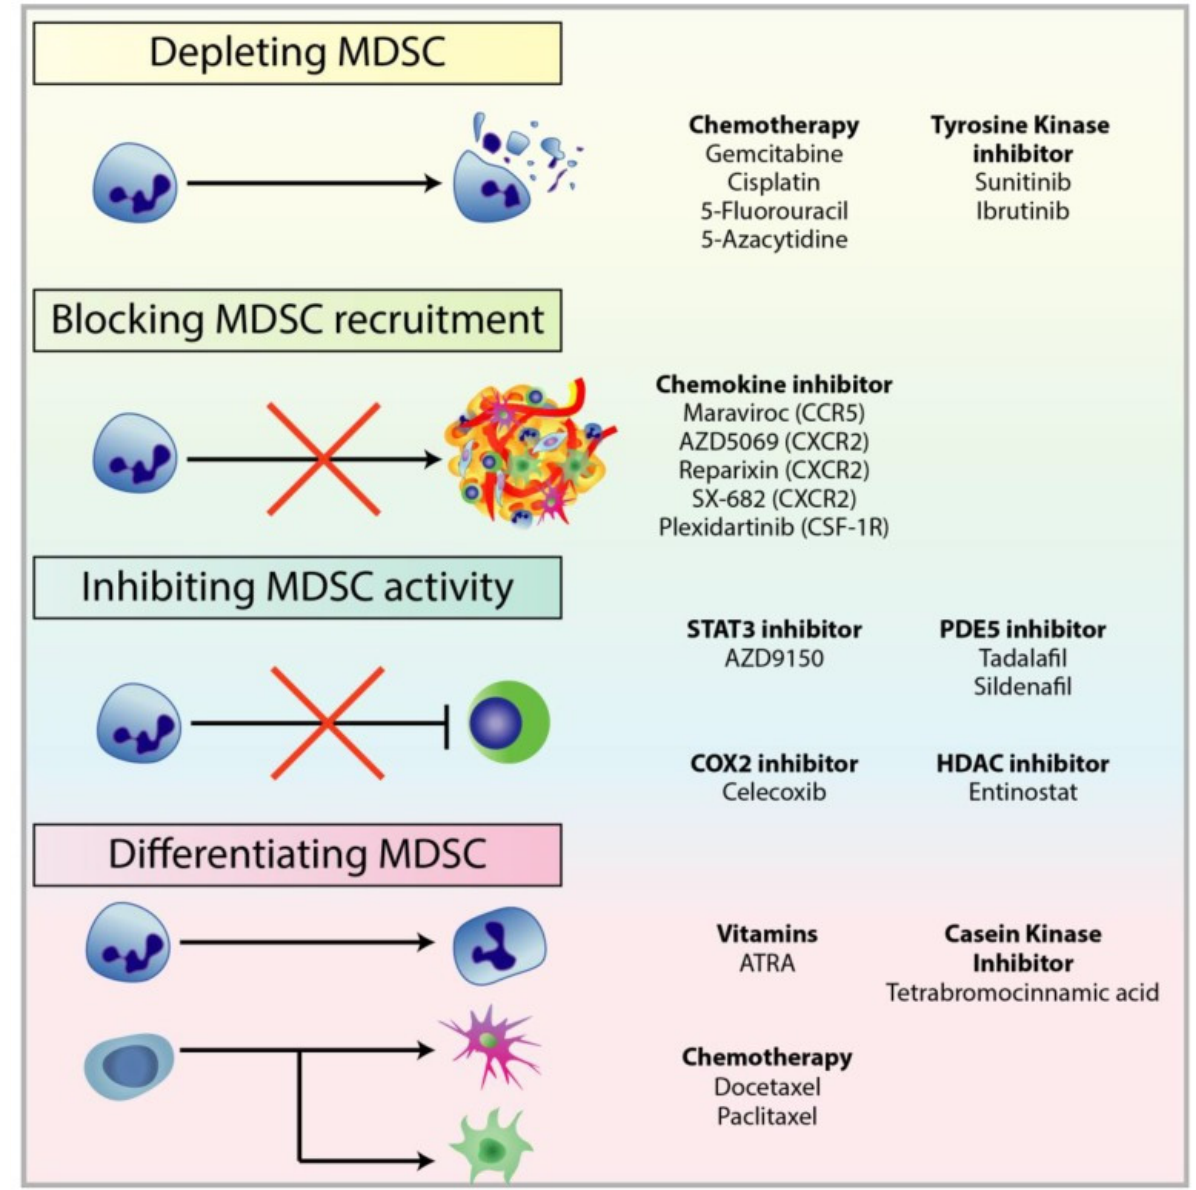
Figure 8. Treatments used to target different mechanisms associated with pro-tumourigenic MDSC. There are multiple therapeutic approaches against MDSC to restore anti-tumour functions in immune cells and improve immunotherapy, in particular checkpoint inhibitors. These approaches include: (1) depleting MDSC populations through low-dose chemotherapy and tyrosine kinase inhibitors; (2) preventing MDSC recruitment to the TME by targeting chemokine receptors responsible for the recruitment and migration of MDSCs; (3) attenuating the immunosuppressive mechanisms of MDSC by downregulating the expression of ARG1 and iNOS, and reducing ROS generation; (4) inducing the differentiation of MDSC into mature myeloid cells to reduce MDSC population and remove their immunosuppression. From Law et al [87].